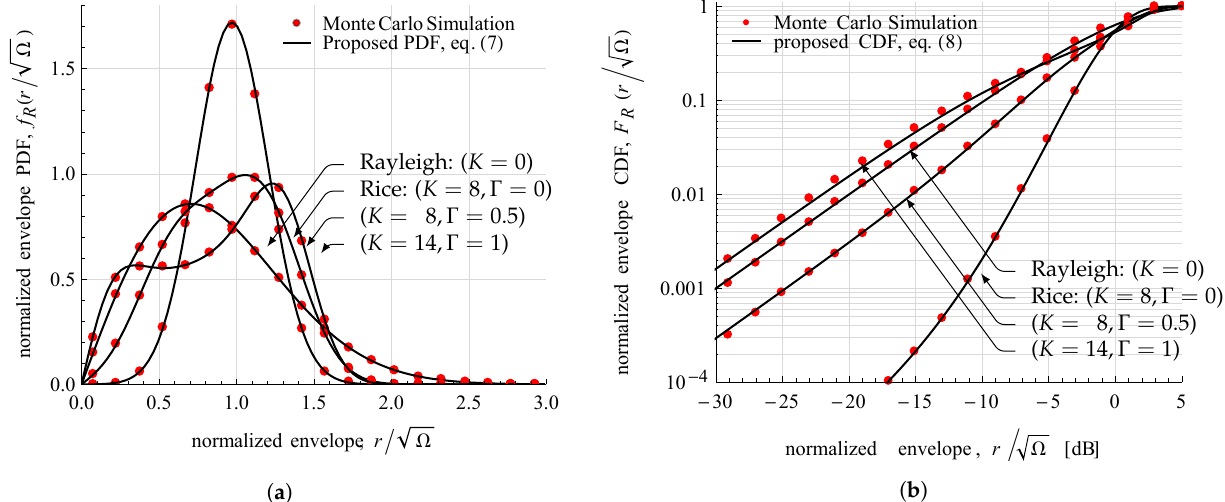
Figure 4. TWDP normalized envelope ( a ) PDF and ( b ) CDF curves for various combinations of K and Γ